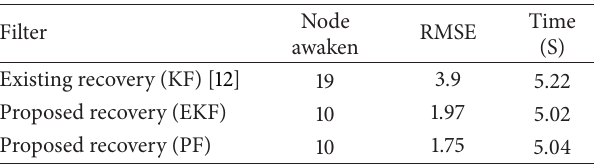
Table 8: Performance comparison: coverage hole in WSHUN—(B) 2nd